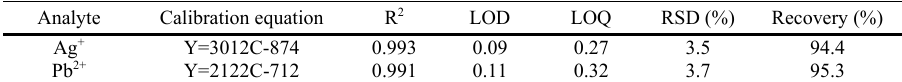
Table 1: Results for determination of analytical parameters for determination of Ag + and Pb 2+ ions using the recommended MSPE procedure. Analyte